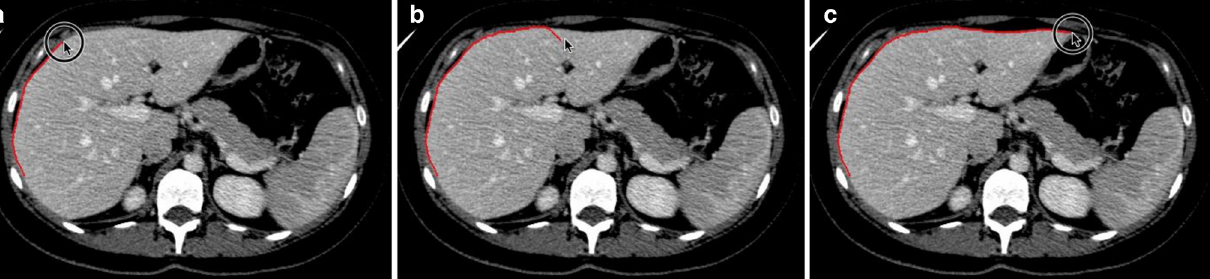
Fig. 10 Livewire technique. a User sets the B seed point ^ by clicking on the liver boundary. b As the cursor is moved, the boundary behaves like a livewire, connecting the seed point to the cursor. c The free point is placed along the liver boundary, and a minimal cost path is generated